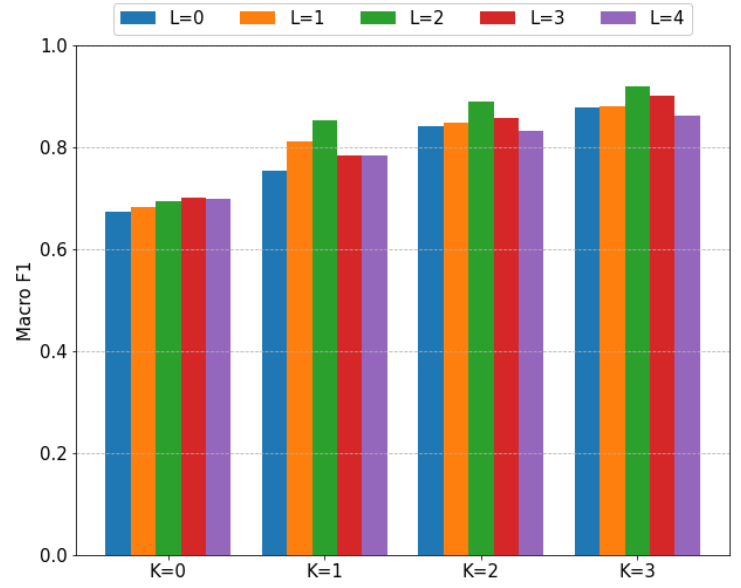
Figure 7. Effect of data augmentation on full-page classification performance (fragment length 64). K specifies the amount of training data augmentation and L specifies the amount of test time data augmentation. Within each grouping, the bars correspond to values of L ranging from 0 (leftmost) to 4